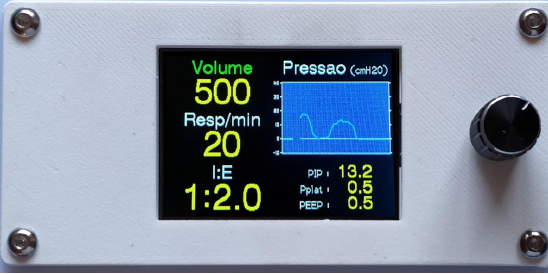
Fig. 9 – Graphical user interface and rotate